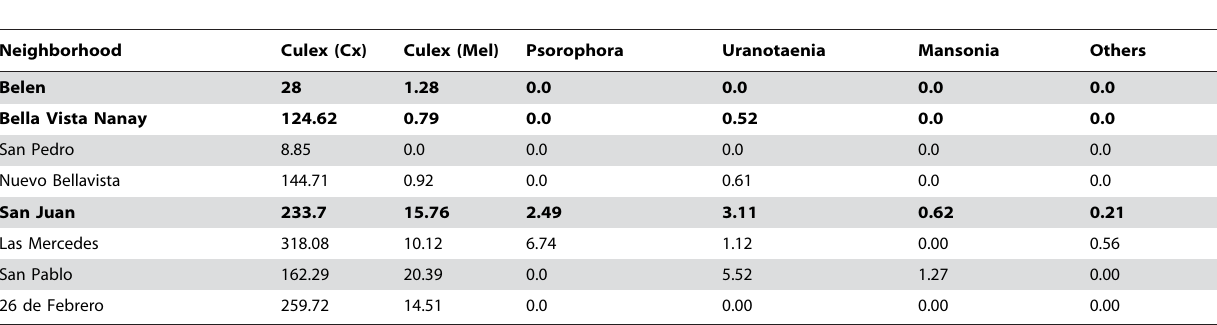
Table 7. Number of adult mosquitoes collected per hectare in house-to-house backpack aspirator collections carried out in October